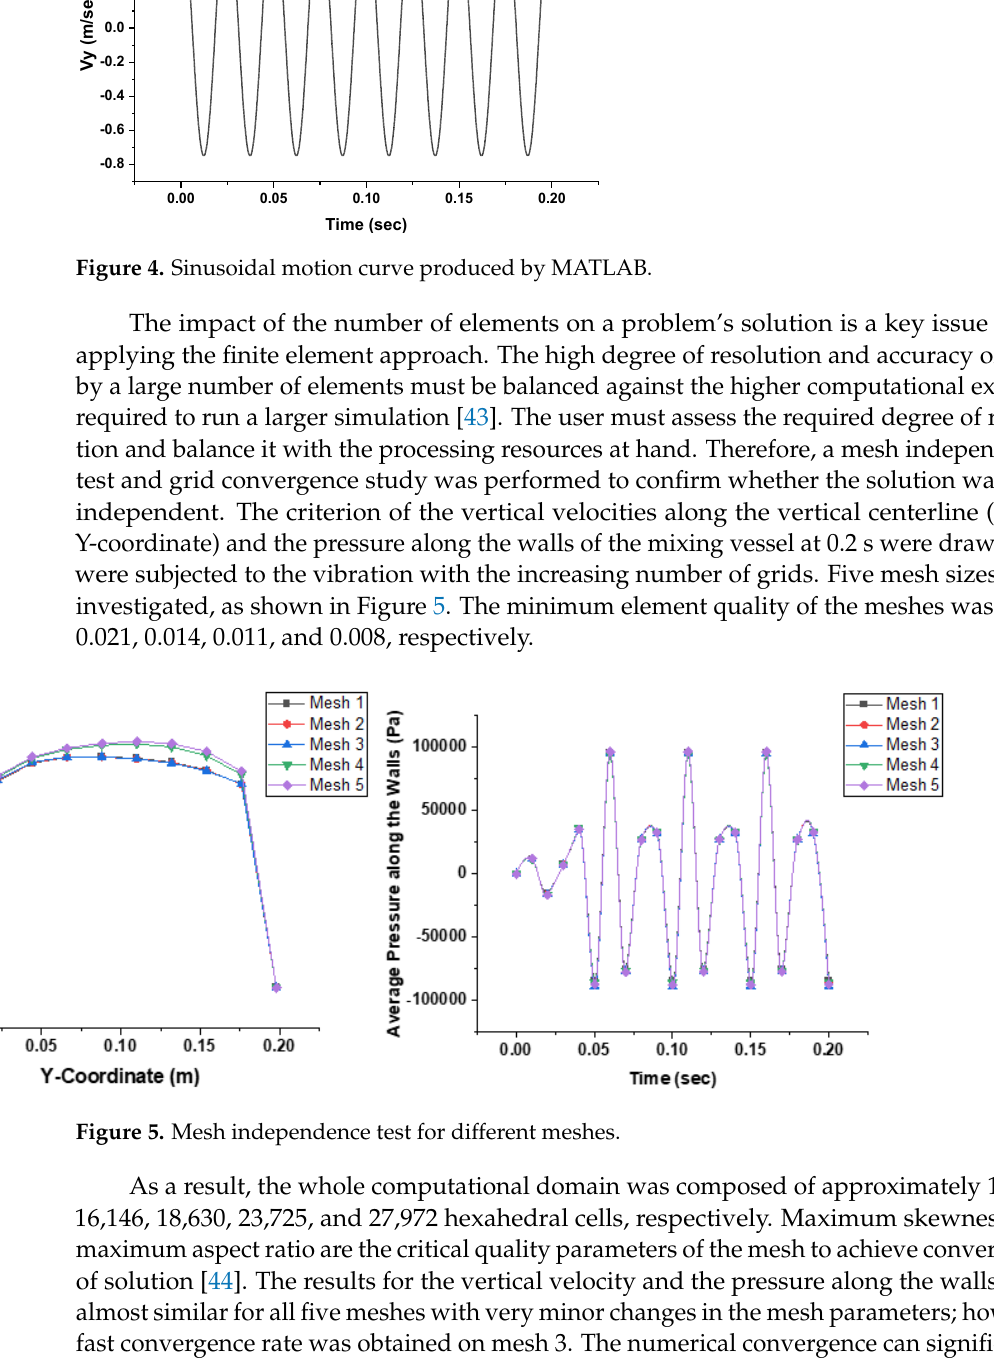
Figure 4. Sinusoidal motion curve produced by MATLAB.